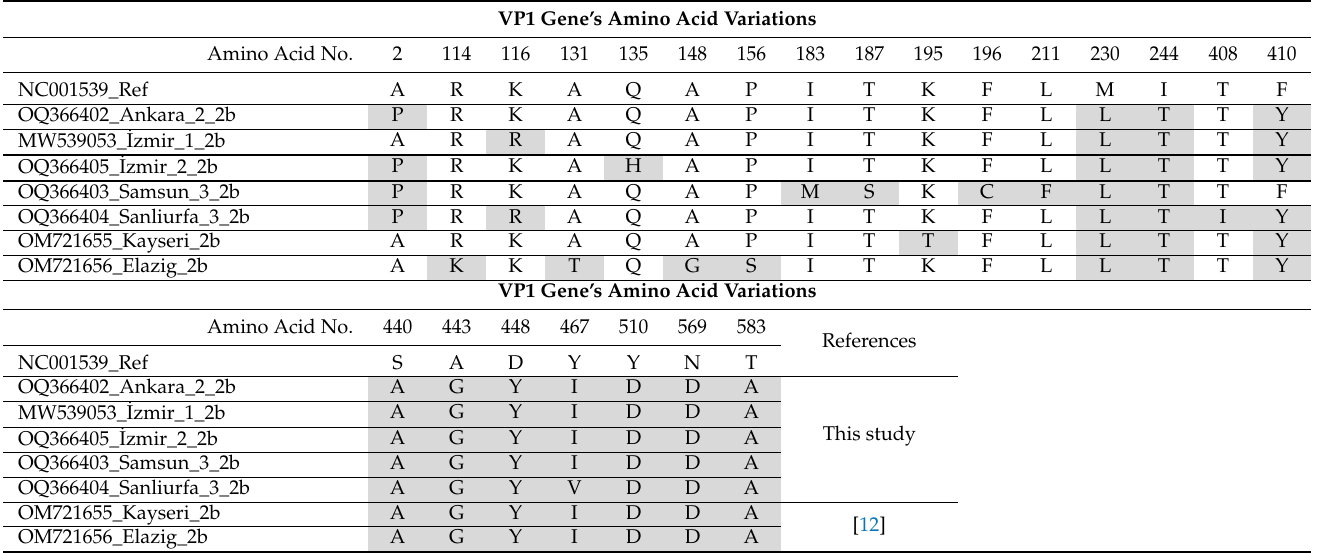
The gray-shaded amino acids are different from the